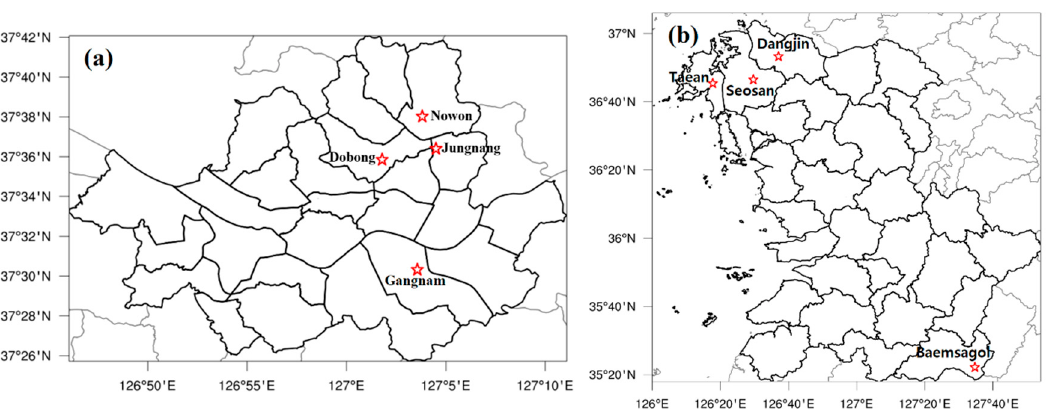
Figure 1. Study areas. The black line on the map denotes the administrative division of city and county unit at ( a ) Seoul and ( b ) Chungcheongnam-do and Jeollabuk-do. Red stars indicate the observational sites used for the verification of hydrological quantitative precipitation forecast (HQPF).